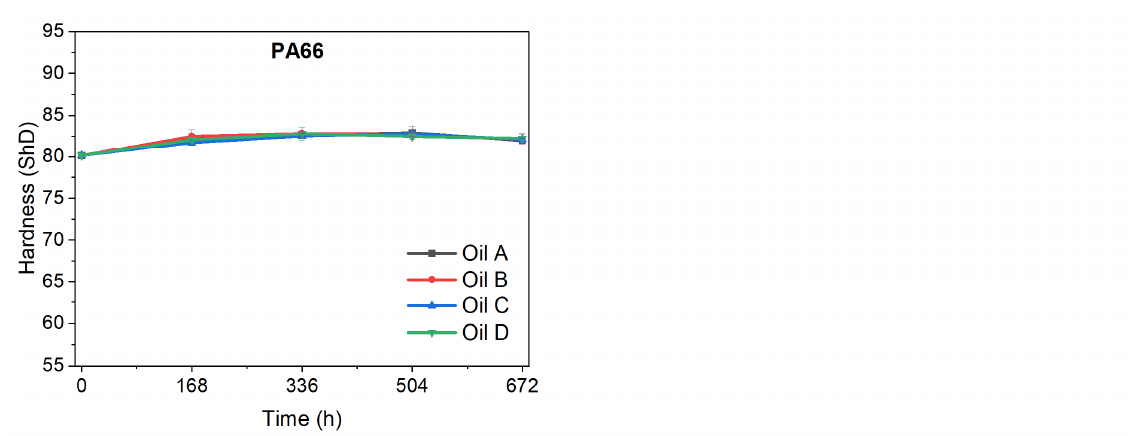
Figure 2. Changes in hardness of PEEK, PTFE, and PA66 (Shore D) after immersion in the ATFs.